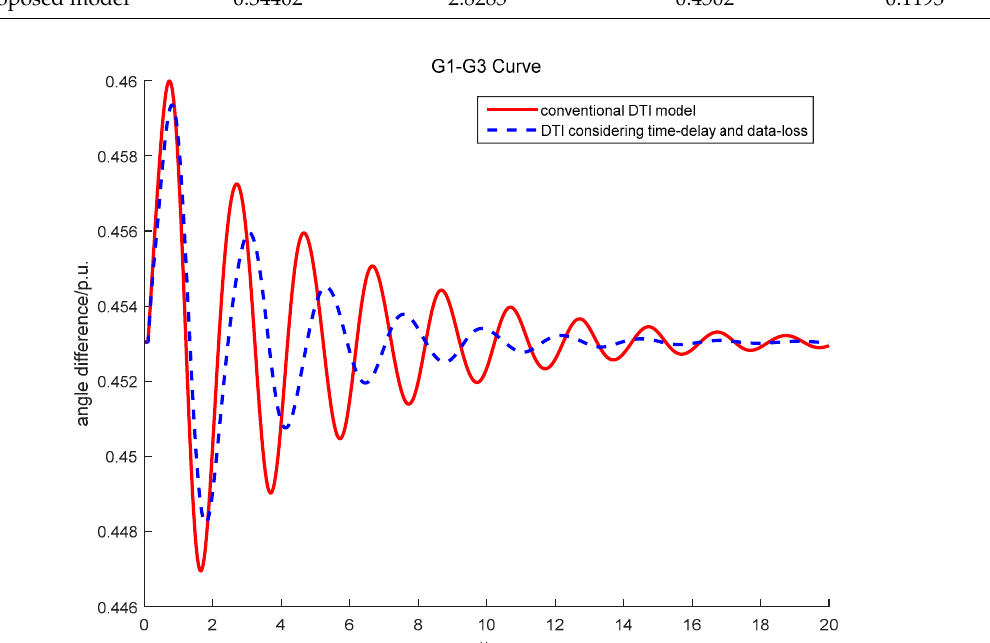
Figure 12. Plots of power angle differences between G1 and G3 tuned by different models.